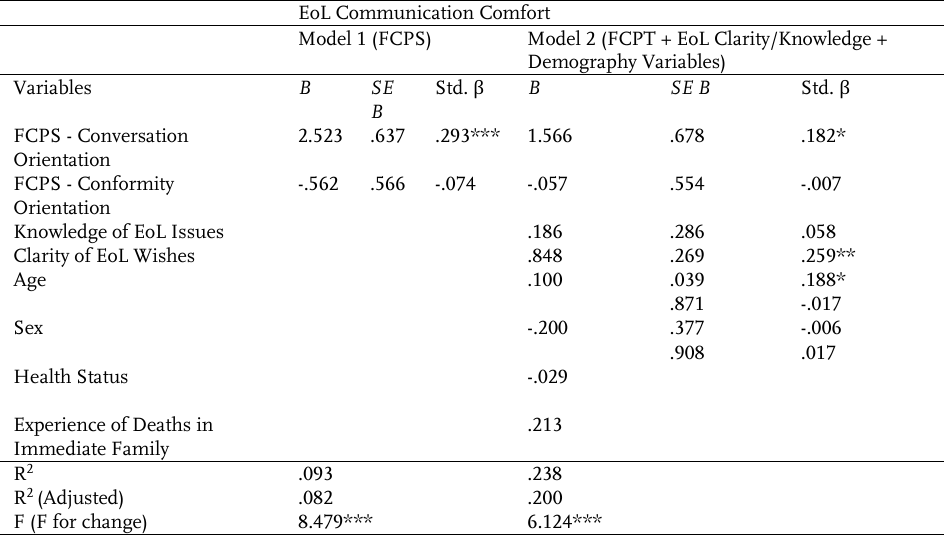
Table 2 : Regression analyses for EoL communication comfort and engagement among middle aged and older